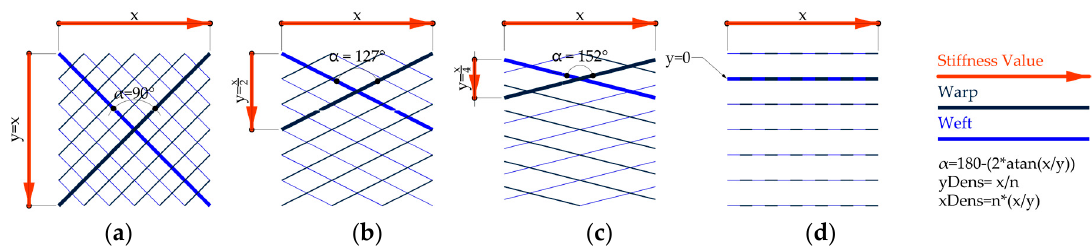
Figure 2. Reinforcement diagrid variations. Bidirectional( a ), intermediate ( b-c ), unidirectional ( d )